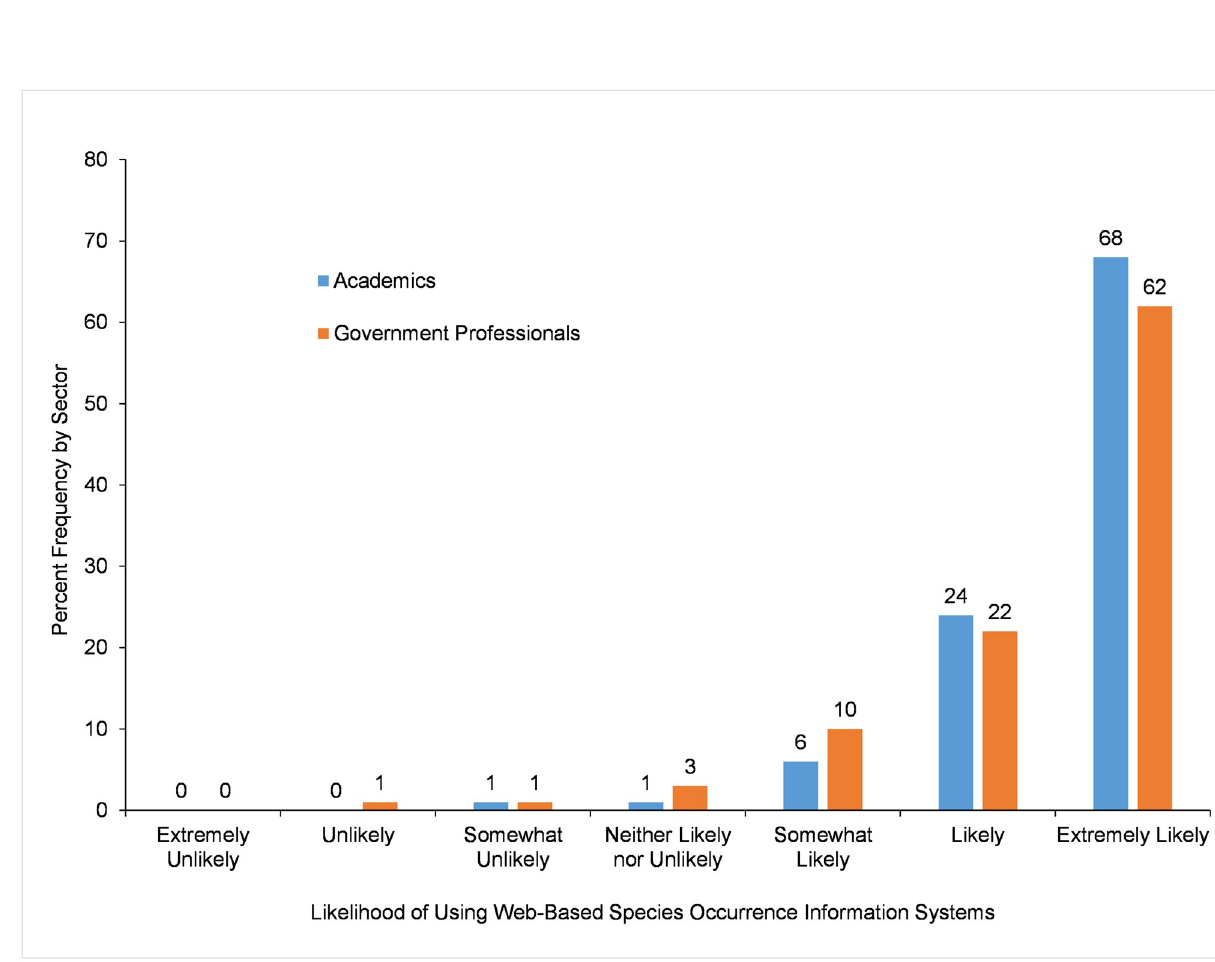
Fig 9. Likelihood of using a web-based species occurrence information system in the next 12